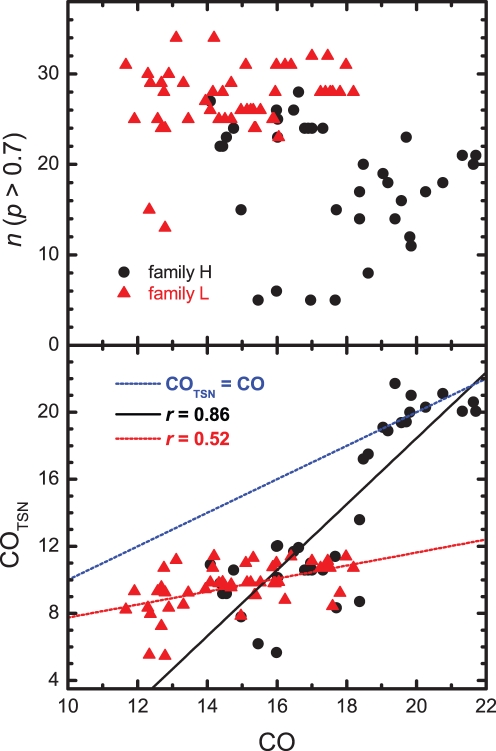
The number of native contacts forming the TSN as a function of CO (top) and the dependence of the contact order of the TSN on the CO (bottom) for families L and H.